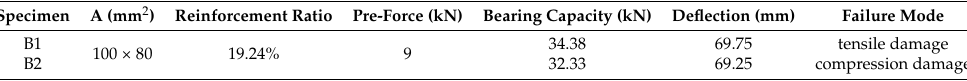
Table 6. Data comparison of two